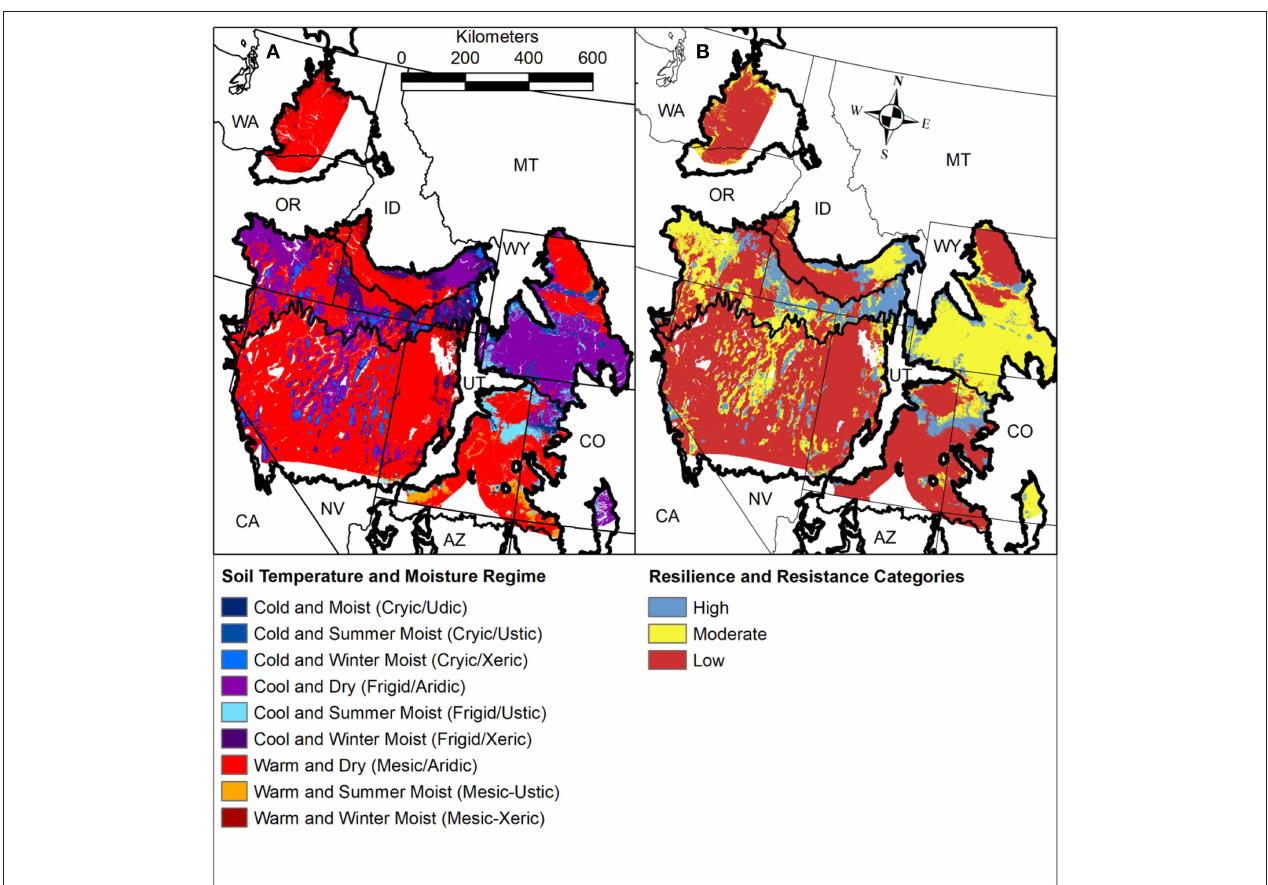
FIGURE 10 | (A) Soil temperature and moisture regimes by moisture subclass derived from the Web Soil Survey for the Cold Deserts in western North America and (B) resilience and resistance categories developed from the soil temperature and moisture regimes (Maestas et al., 2016; Chambers et al., 2017a).